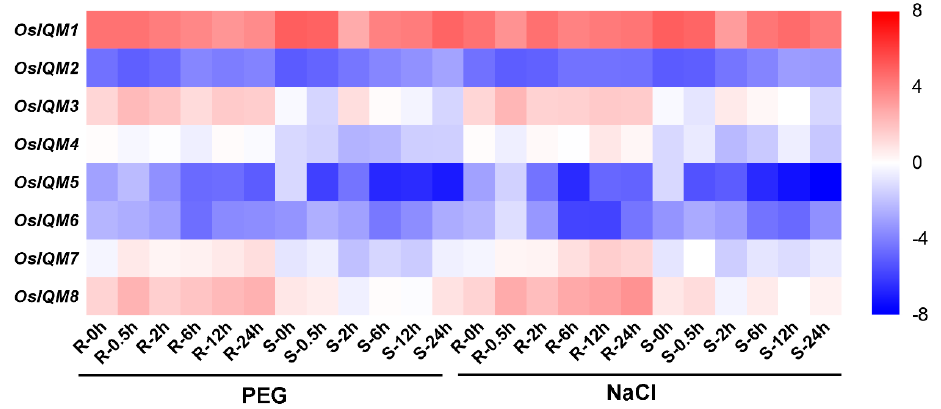
Figure 8. Heat map of the real-time quantitative PCR (qRT-PCR) analysis results of OsIQMs genes in shoots and roots under PEG and NaCl treatment, with three biological and technical replicates. The scale representing the relative signal intensity values is shown above.